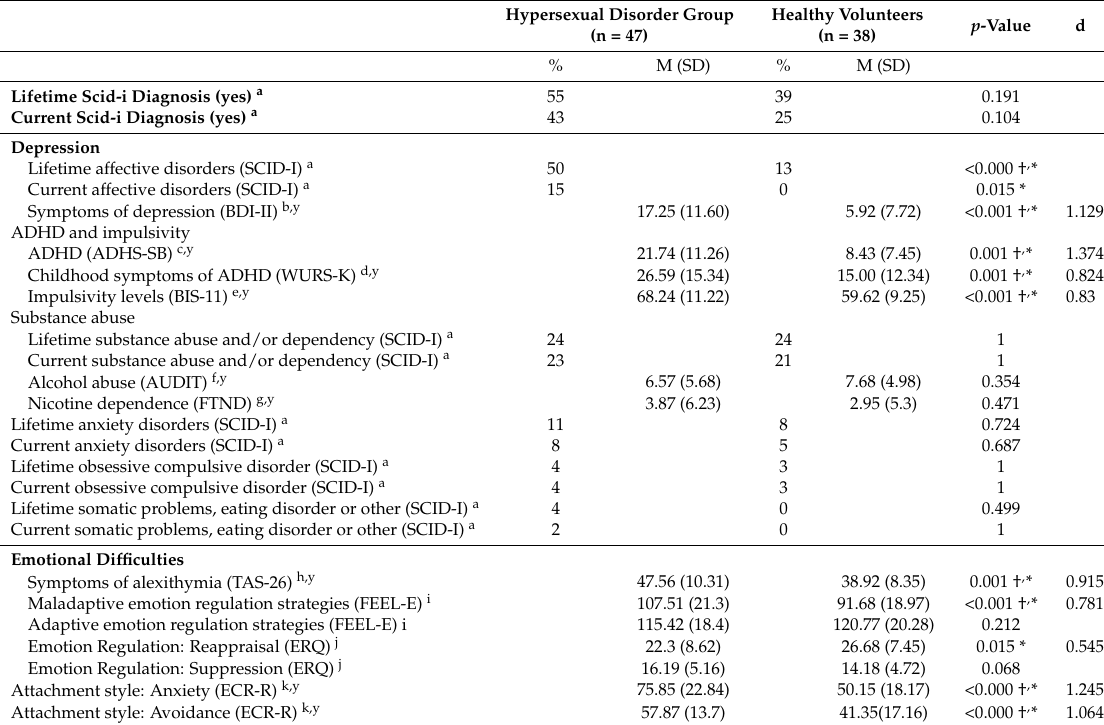
Table 4. Psychological characteristics and